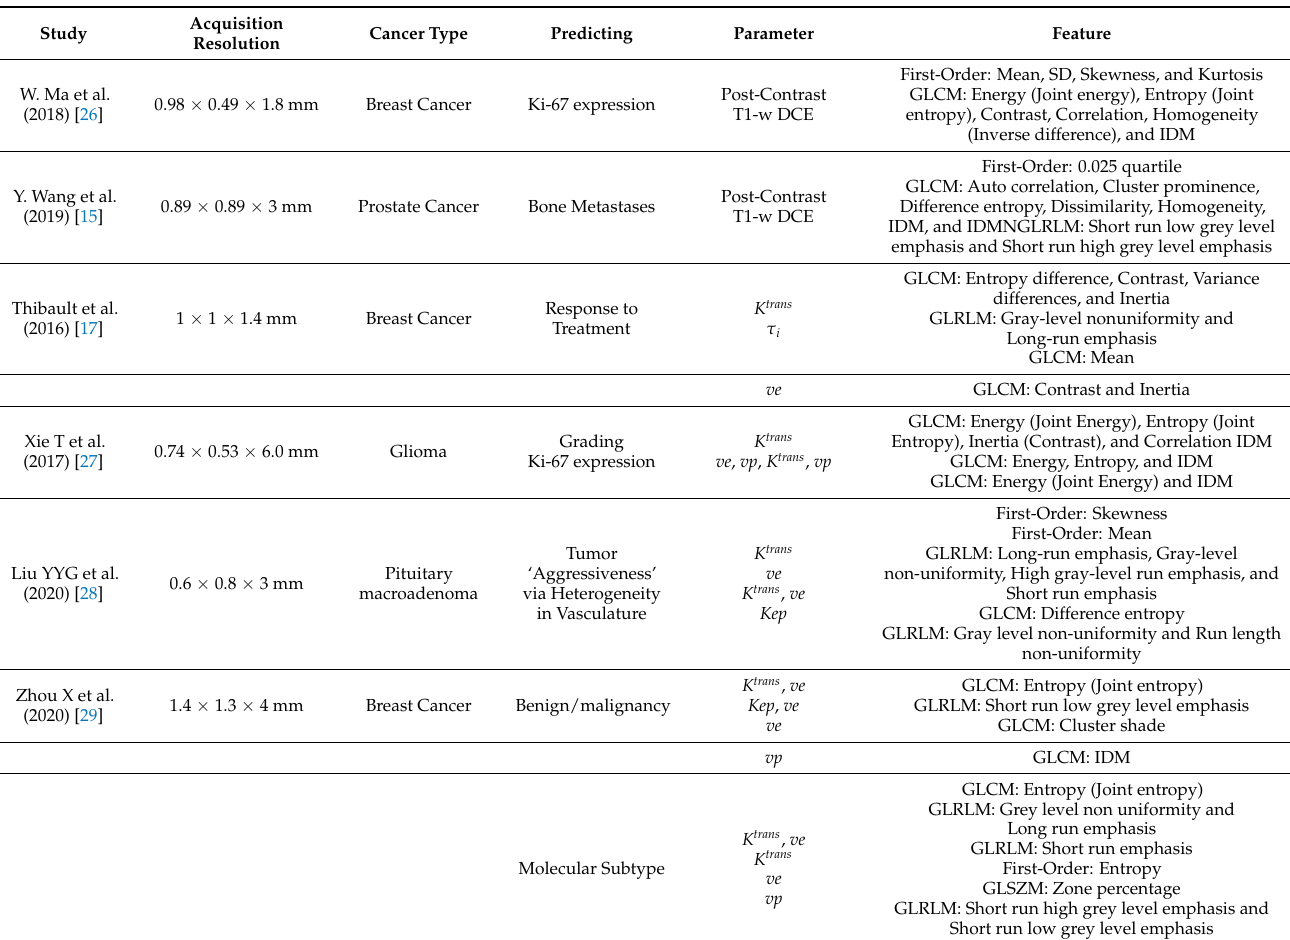
Table 1. Summary of pharmacokinetic parameters from DCE-MRI studies that were found significant by the radiomic